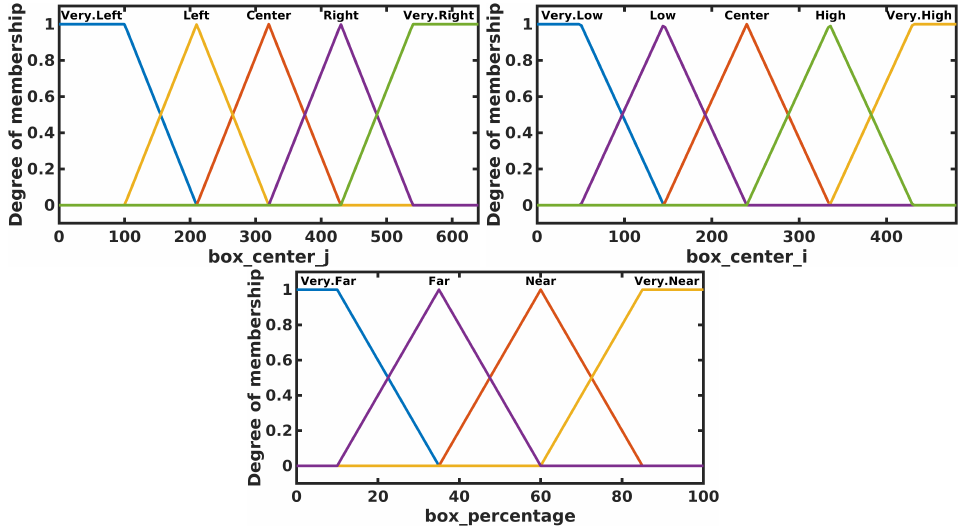
Figure 11. Input